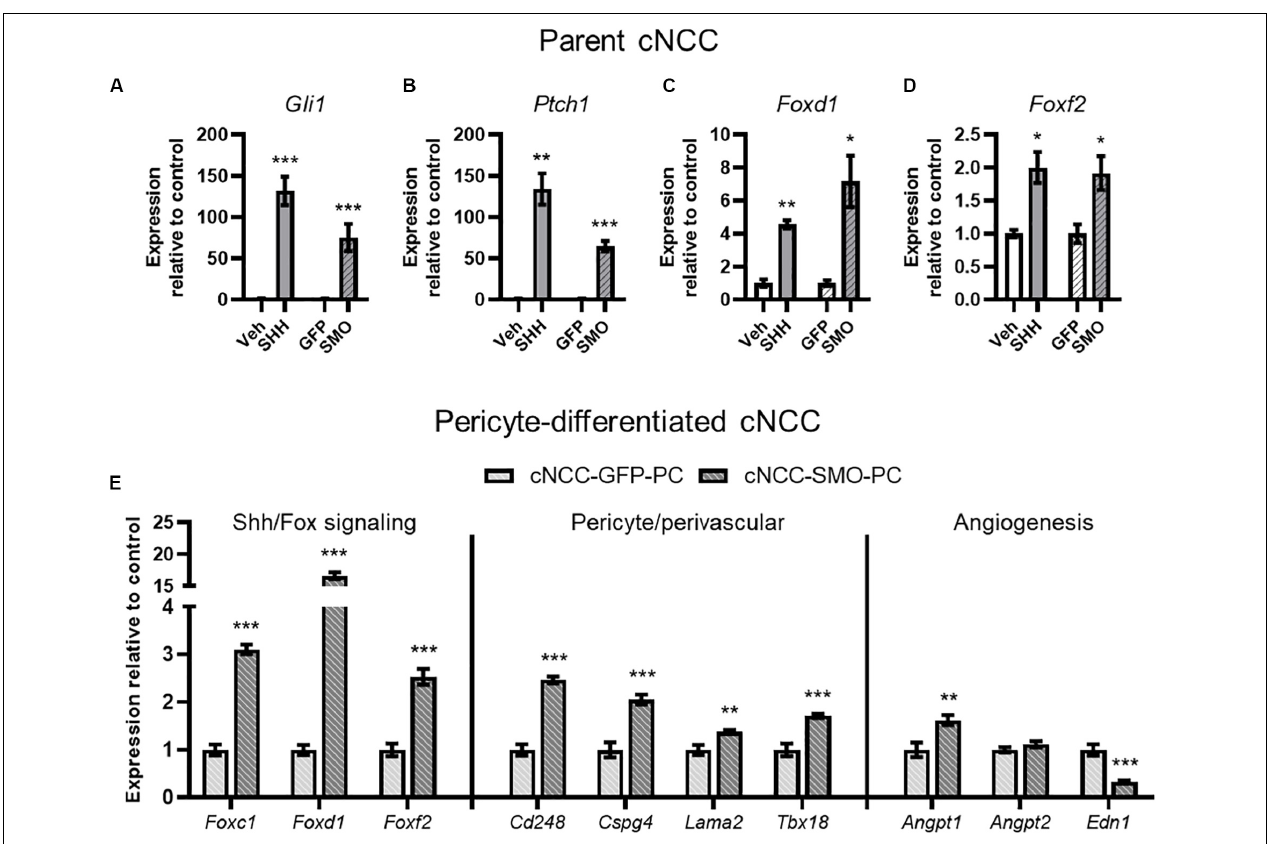
FIGURE 5 | cNCC-autonomous Shh pathway activation increases pericyte-associated gene expression. (A–D) SHH ligand treatment or expression of the constitutively active SMO M 2 (SMO) induces expression of Shh target genes Gli1 and Ptch1 in addition to Shh pathway-regulated Forkhead box transcription factor (Fox) genes. (E) Shh/Fox genes, pericyte/perivascular genes, and angiogenic genes are regulated by cNCC-autonomous Shh pathway activation in pericyte-differentiated cNCCs. Five biological replicates were analyzed for all groups. * p < 0.05, ** p < 0.01, and *** p < 0.001 compared to respective control